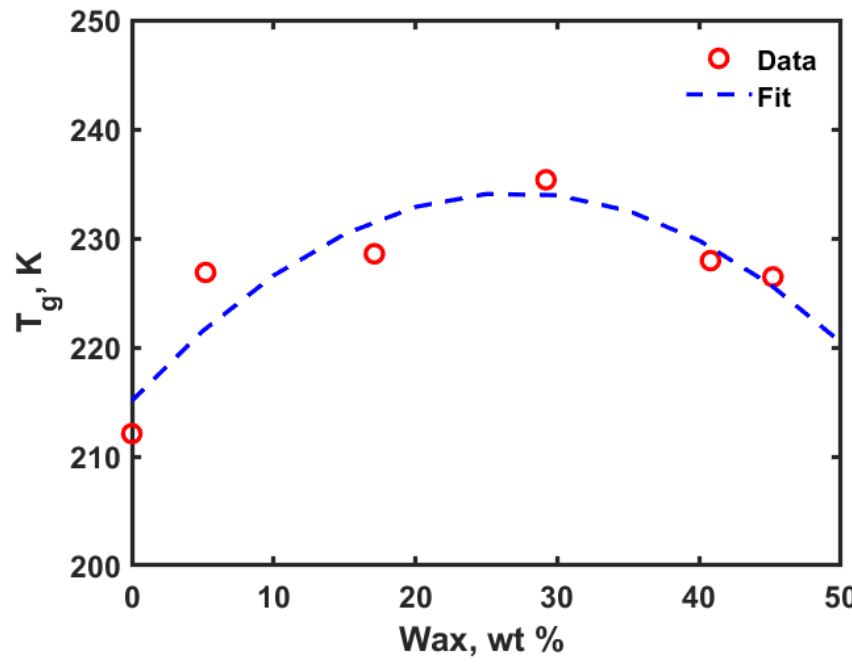
Figure 7. Glass transition temperature versus weight percent of wax in polymer blends.